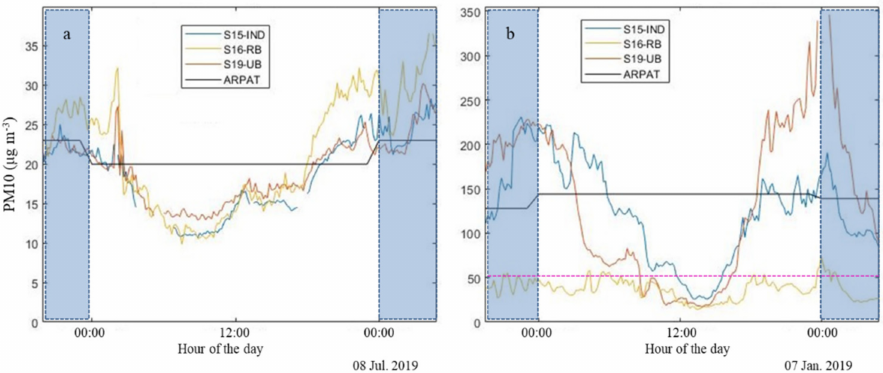
Figure 5. Examples of ( a ) summer and ( b ) winter daily patterns at high-frequency (10-min) scale of PM 10 concentrations observed by S15-IND, S16-RB, and S19-UB stations as compared to those observed at low-frequency (24-h) scale by the ARPAT reference station. The dotted purple line denotes the PM 10 daily limit